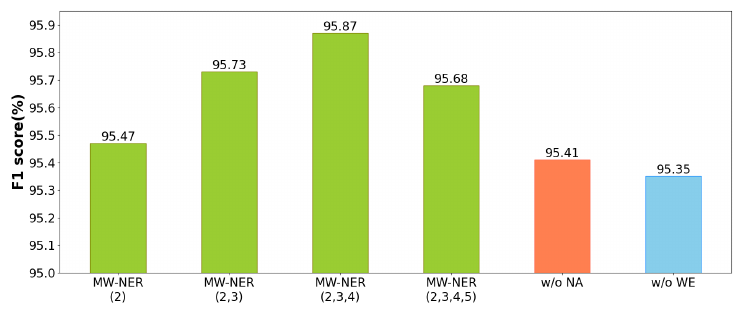
Figure 5. F1 scores of different models on Resume